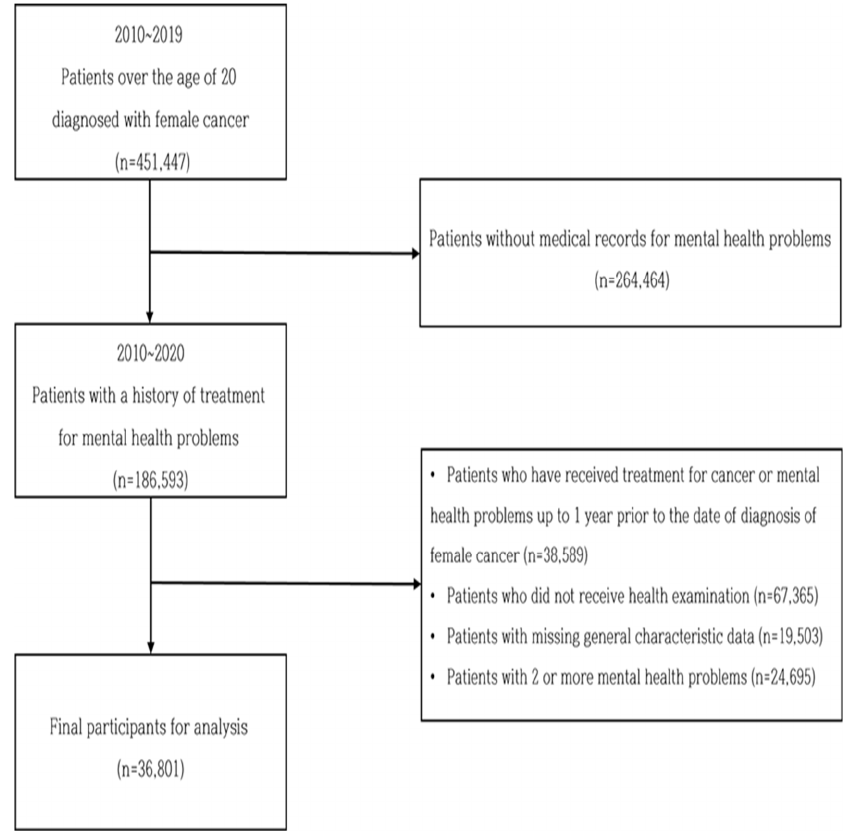
Figure 1. Flow chart of study participants.